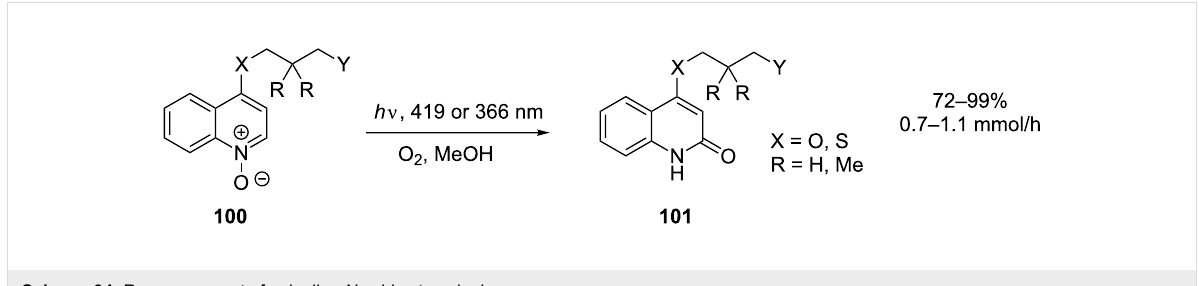
Scheme 34: Rearrangement of quinoline N -oxides to